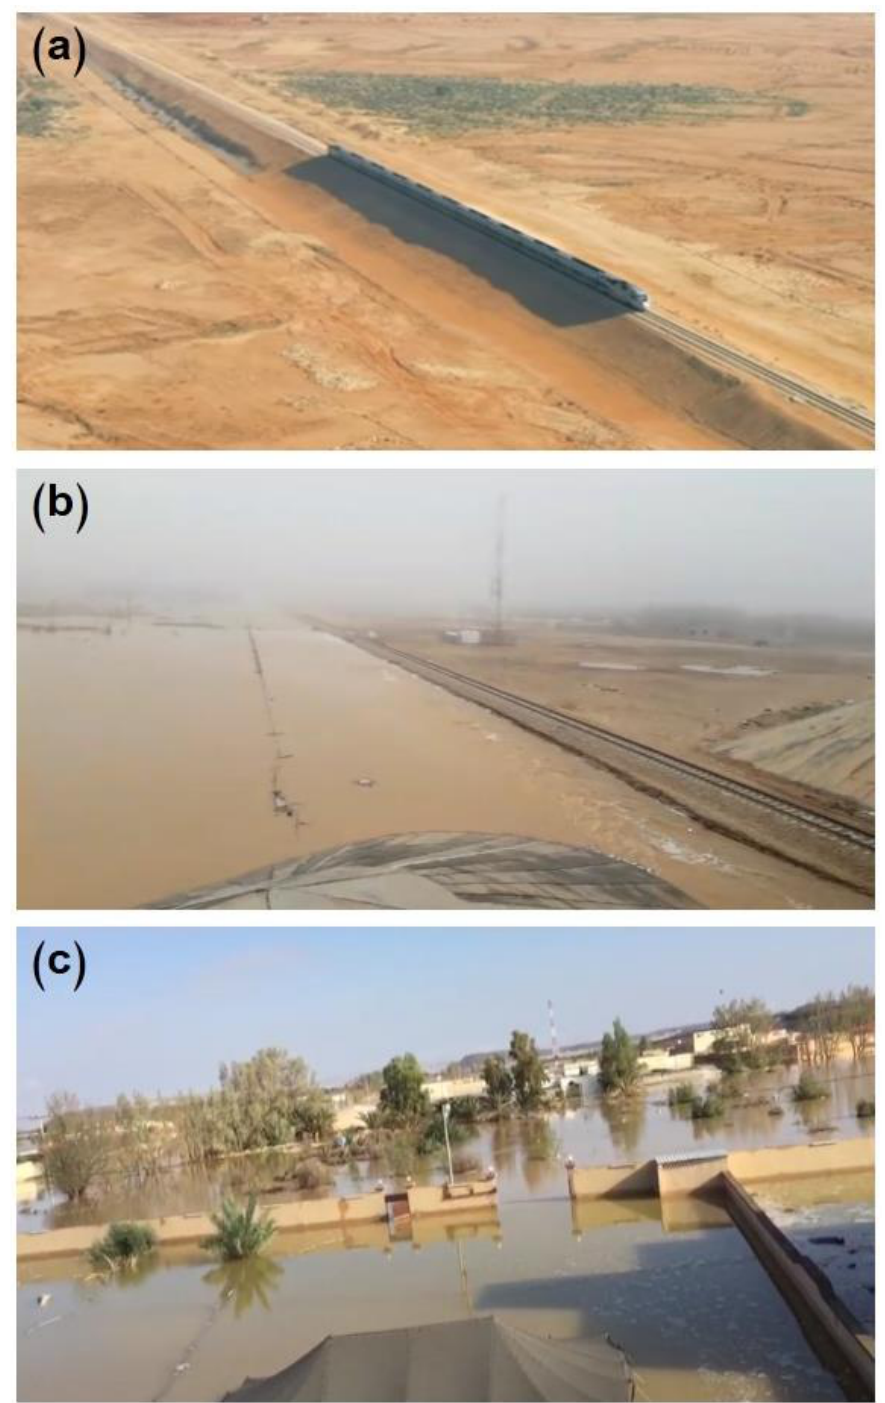
Figure 1. ( a ) Change in the natural appearance of land-use due to the presence of the Al-Shamal train pathway, which impedes the natural wadi runoff; ( b ) detaining of Wadi Bayer floodwater in front of the Al-Shamal train pathway on 10 November 2018; and ( c ) flooding of Bayer village due to the detaining of floodwater in front of the Al-Shamal train pathway on 10 November 2018.